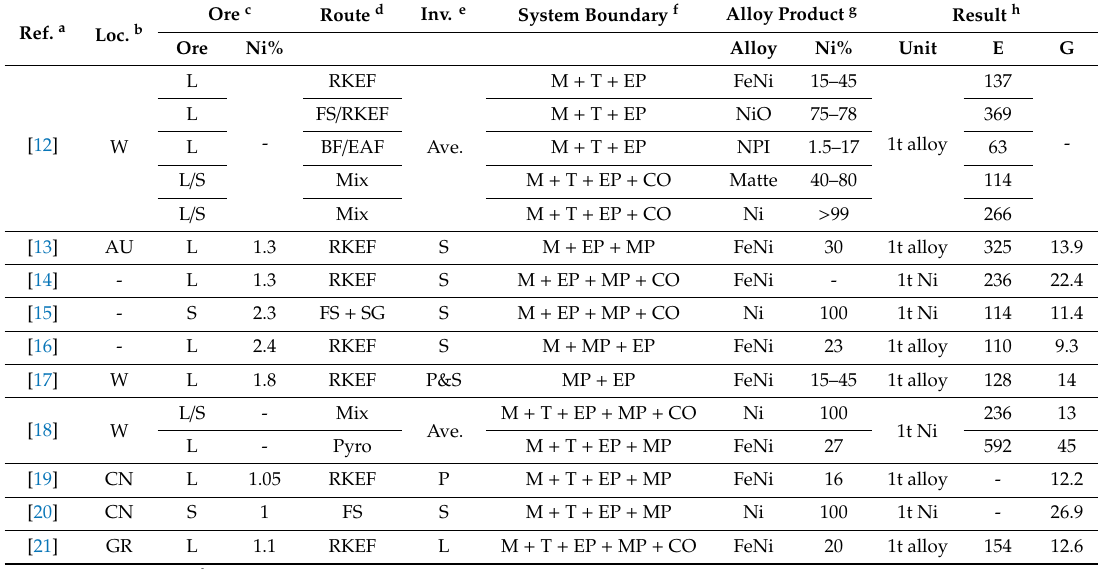
Table 1. Published LCA studies of nickel